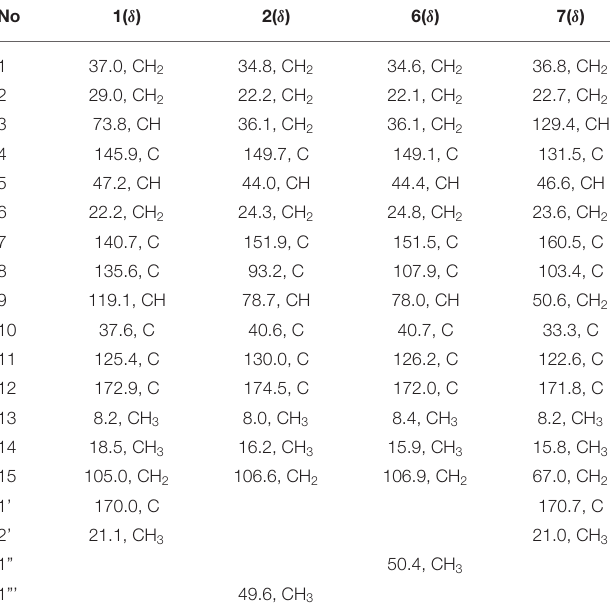
= 24.2 min). All these R